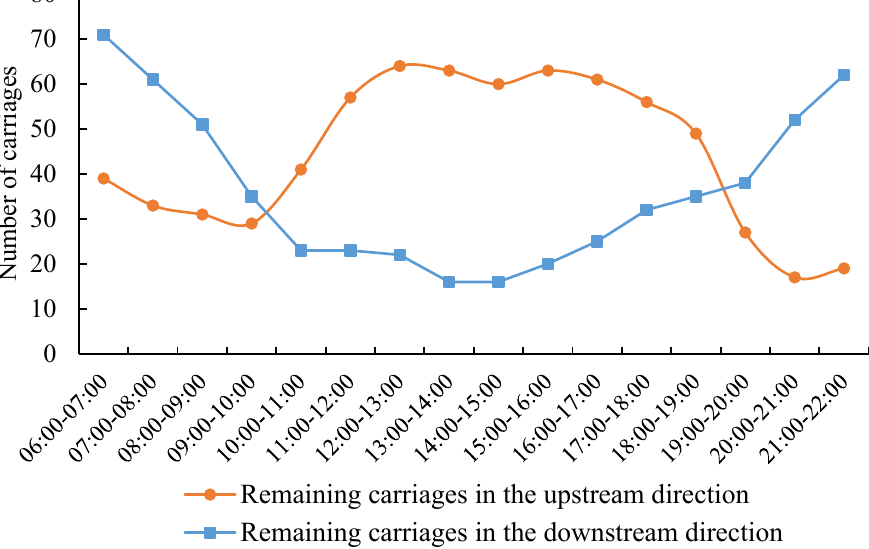
Figure 7. The number of remaining carriages in each period.